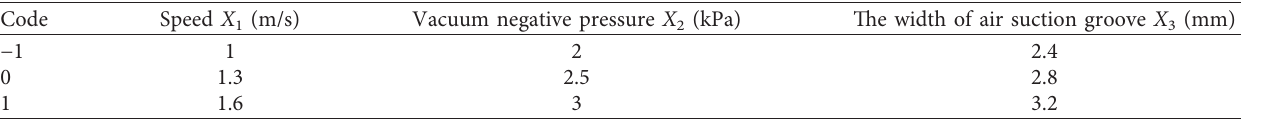
Figure 13: Seeds fall in different intervals. (a) Drop in the front. (b) Drop in the middle. (c) Drop in the end. Table 2: Experimental factors of codes.